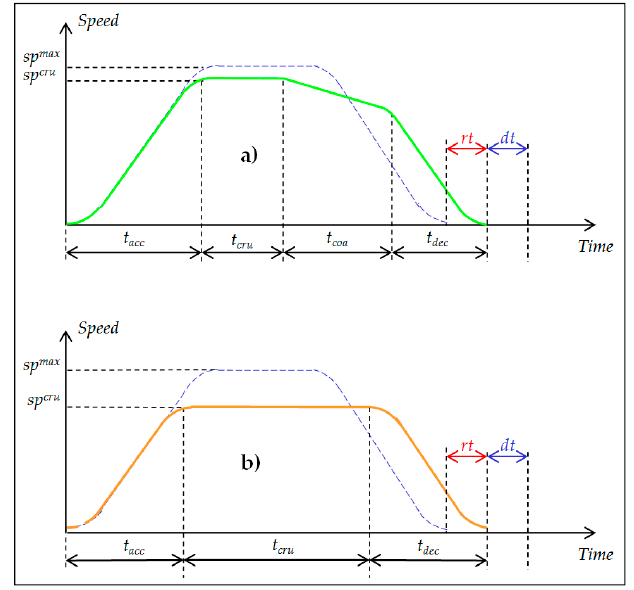
Figure 3. Energy-saving driving styles: ( a ) With a coasting phase; ( b ) without a coasting phase. t coa , the duration of the coasting phase; sp cru , the (optimised) cruising speed.